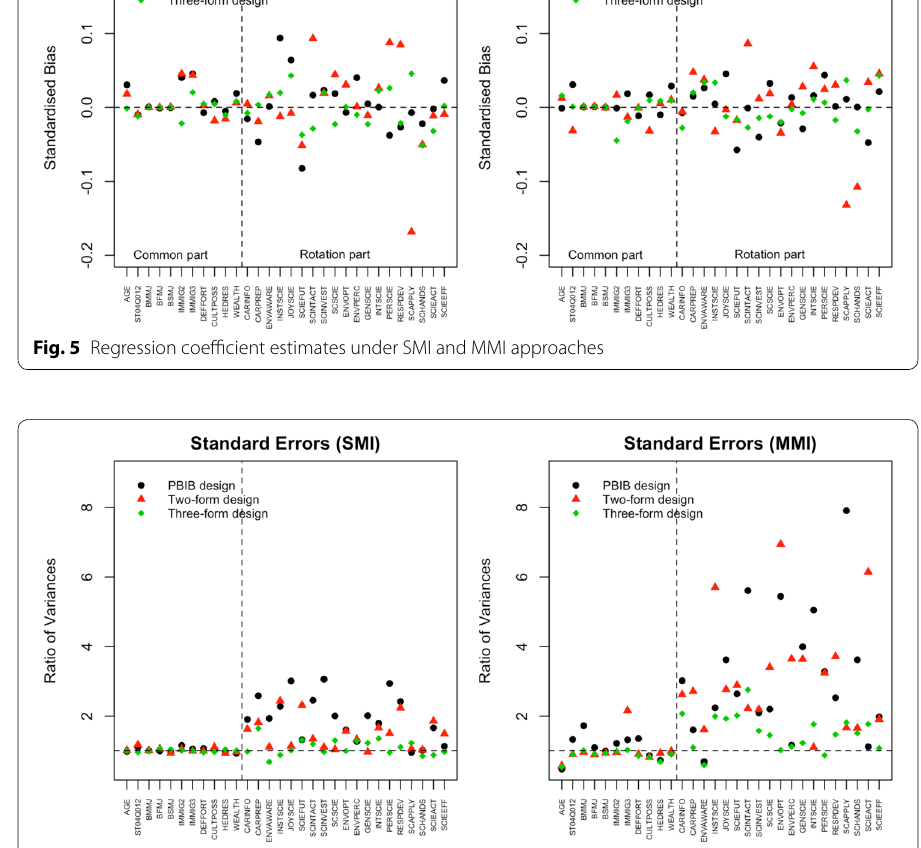
Fig. 6 Standard errors of the regression coefficients under SMI and MMI